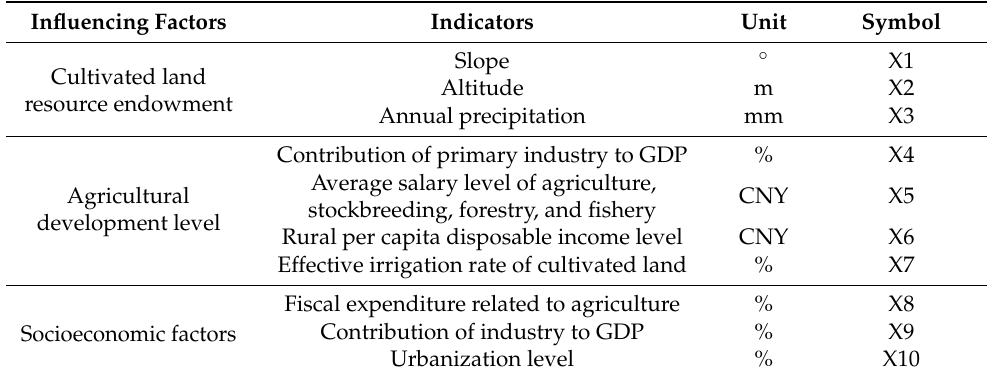
Table 2. Selection of factors influencing the multifunctional coupling coordination degree of cultivated land in the study areas. Influencing Factors Indicators Unit Symbol Cultivated land resource endowment